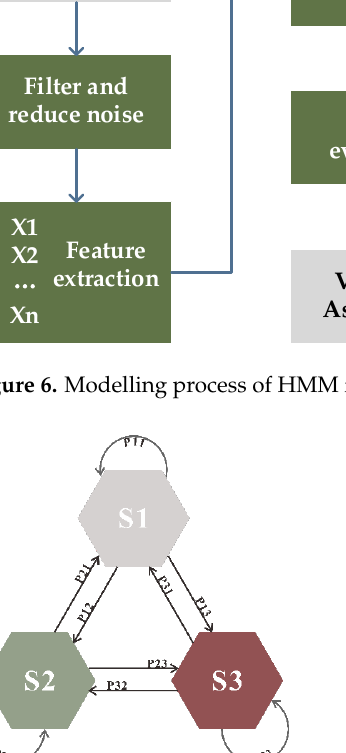
Figure 6. Modelling process of HMM for vigilance assessment.